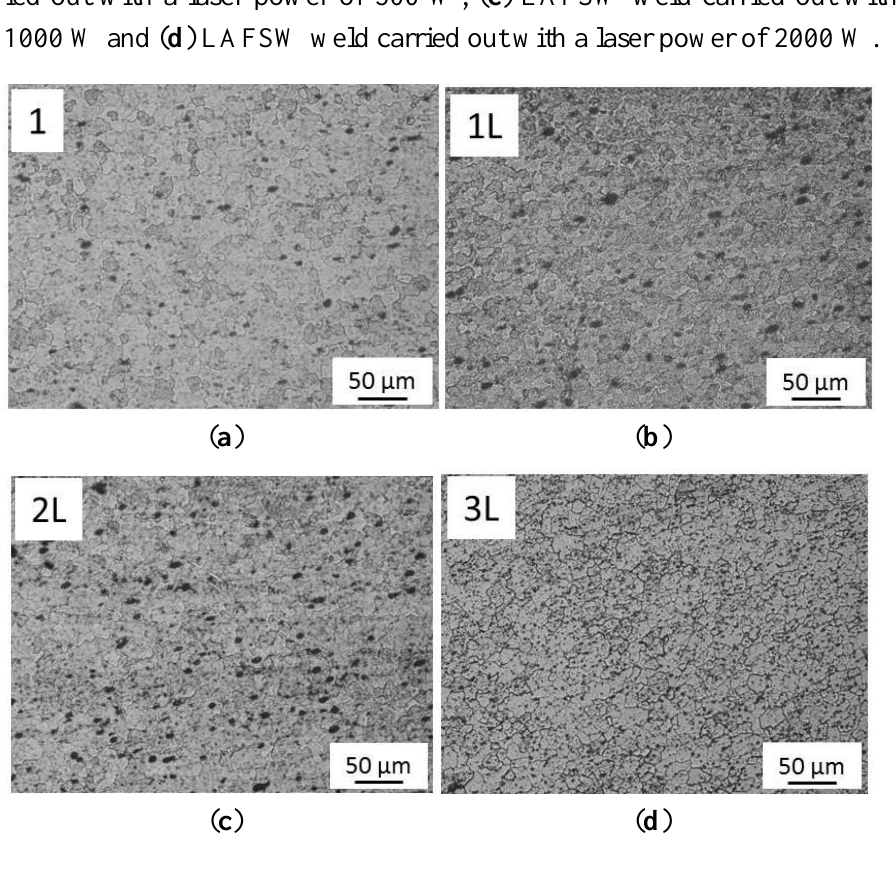
Figure 8. Microstructure of the base material (100×